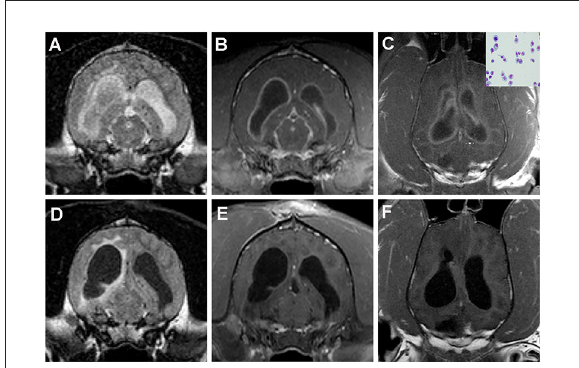
FIGURE4 Intracranial plasma cell tumor in a dog treated with IT methotrexate. (A) The neoplasm manifests on imaging as diffuse meningitis and ventriculitis, as evidenced by the intra-and paraventricular FLAIR hyperintensities (A) and diffuse meningeal and ependymal enhancement on the post-contrast T1W images (B,C) . Neoplastic plasma cells can be observed in the CSF cytospin preparation ( C , inset). One month after treatment, the previous hyperintense FLAIR CSF signal has resolved, although paraventricular hyperintensity persists (D) , and improvement in the contrast-enhancing lesion burden is noted (E,F) .